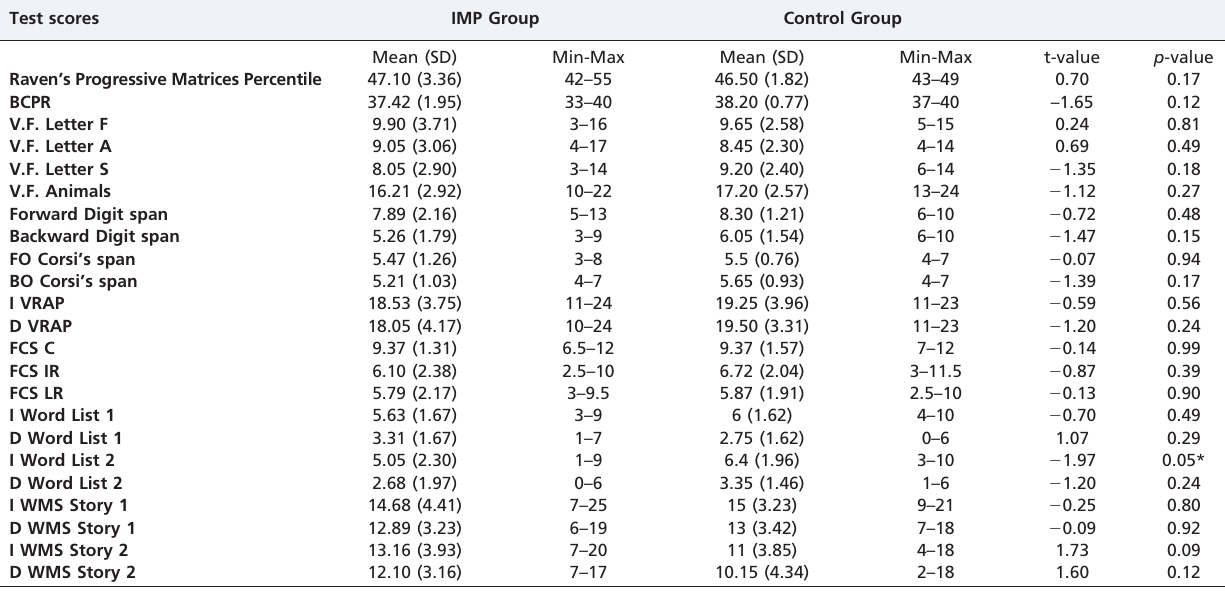
Table 2 - Neuropsychological assessment in adolescents with IMP (N = 19) and controls (N = 20) (mean ¡ [SD]). Test scores IMP Group Control Group